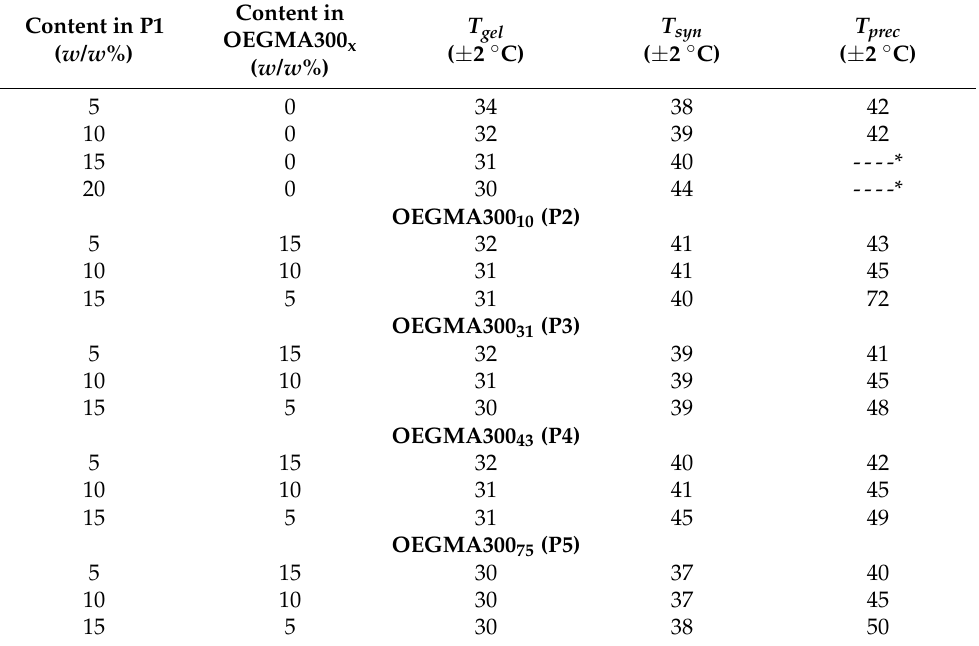
Table 2. Important phase transitions recorded by visual tests in phosphate buffered saline (PBS): gelation temperature ( T gel ) and temperatures at which gel syneresis ( T syn ) and precipitation ( T prec ) were observed. Content ( w/w %)